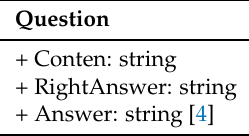
Table 3. Model of questions.